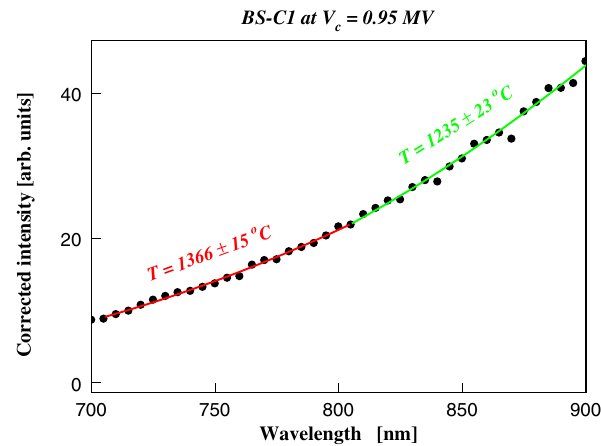
FIG. 17. Example of a physical spectrum (corrected spectrum) obtained for BS-C1. The red and green curves are the results of fitting the data with Planck ’ s law of Eq. (1) in the wavelength regions of 700 to 800 nm and 800 to 900 nm, respectively. The temperatures obtained from these fitting results are also given.